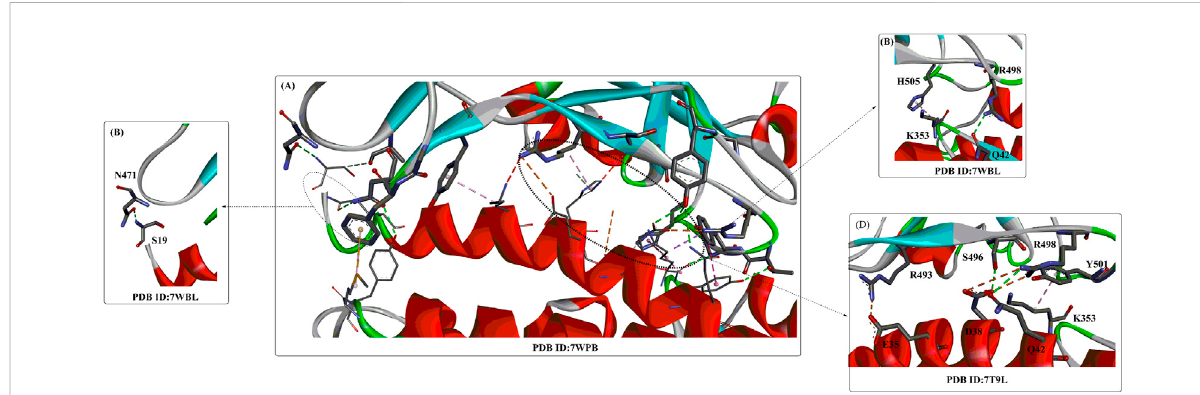
FIGURE 6 The interaction modes of the Omicron spike protein and ACE2.